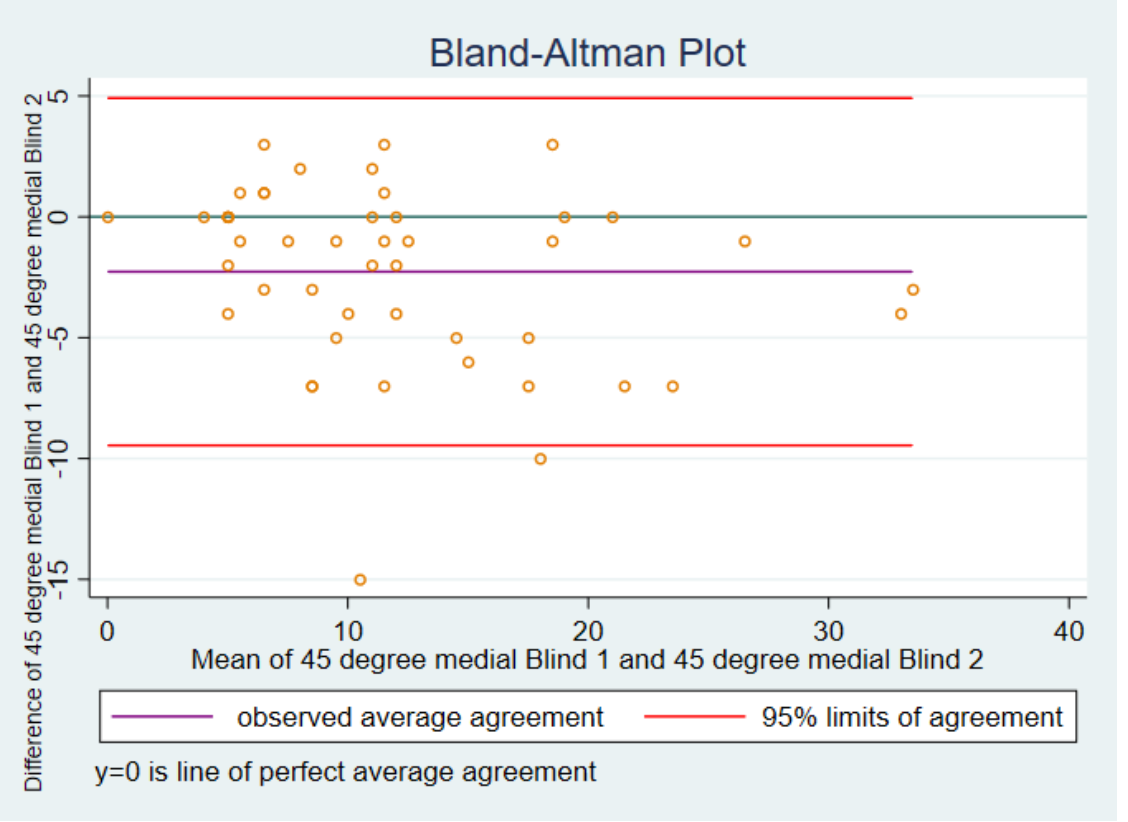
Figure A2. Forty-five degrees, medial.